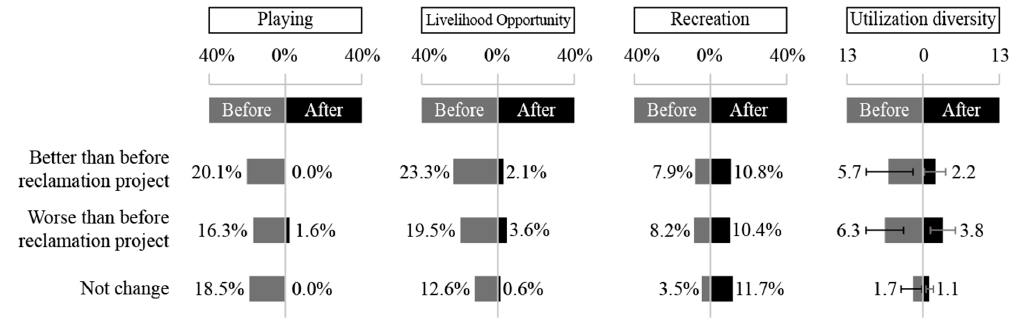
Figure 12. Ratio of answers to “no change in Fukushima-gata lagoon before and after the reclamation project”.